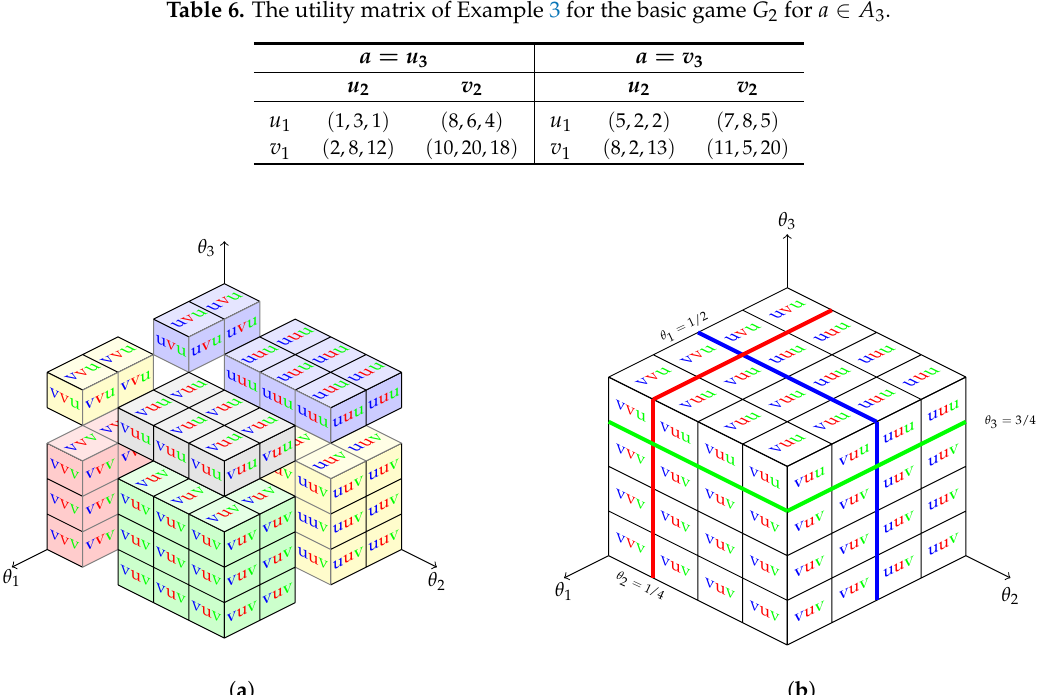
Figure 2. The partitioning of Θ in Example 3 into regions of constant local NE for G